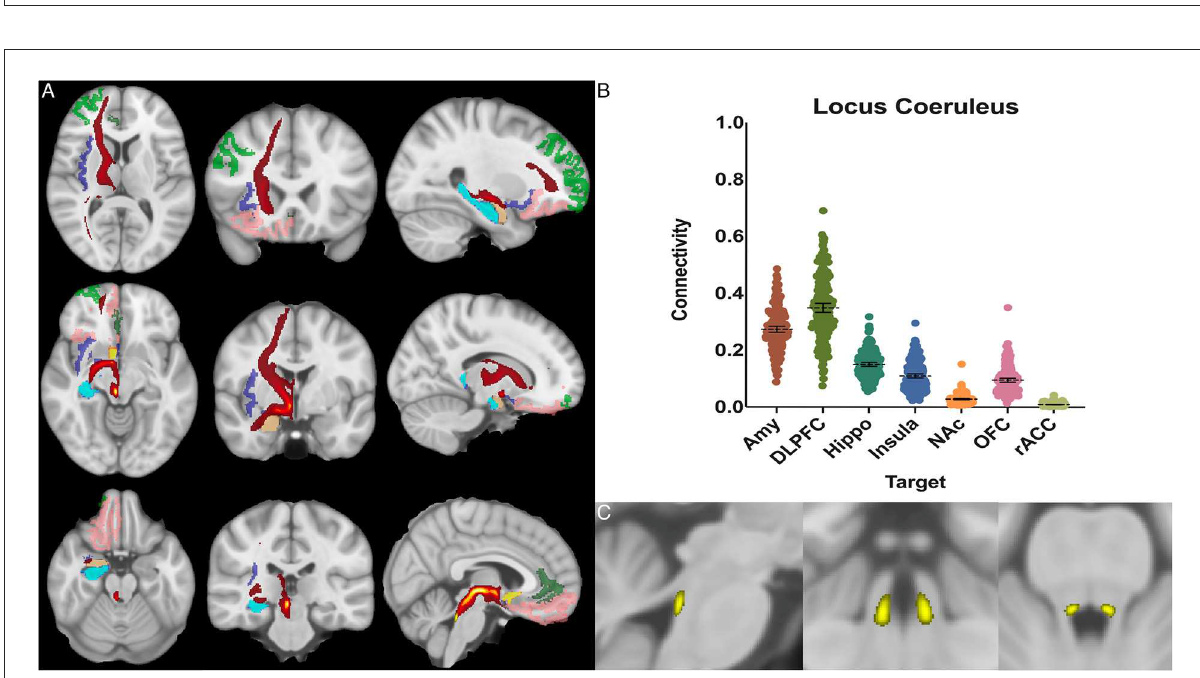
FIGURE4 Locus coeruleus structural results. (A) MNI space structural connectivity results visual representation averaged over all 197 subjects. Brighter yellow on heat map indicates a high number of samples passing through a given point that will eventually reach a target map (brighter yellow = more samples). Dark green: DLPFC; pink: OFC; brown: AMY; blue: HIPPO; purple: insula; orange: NAc; light green: rACC. (B) Mean connectivity results with dashed line showing mean and 95% CI, each point on graph shows result from individual subject. (C) Anatomic MNI mask of seed